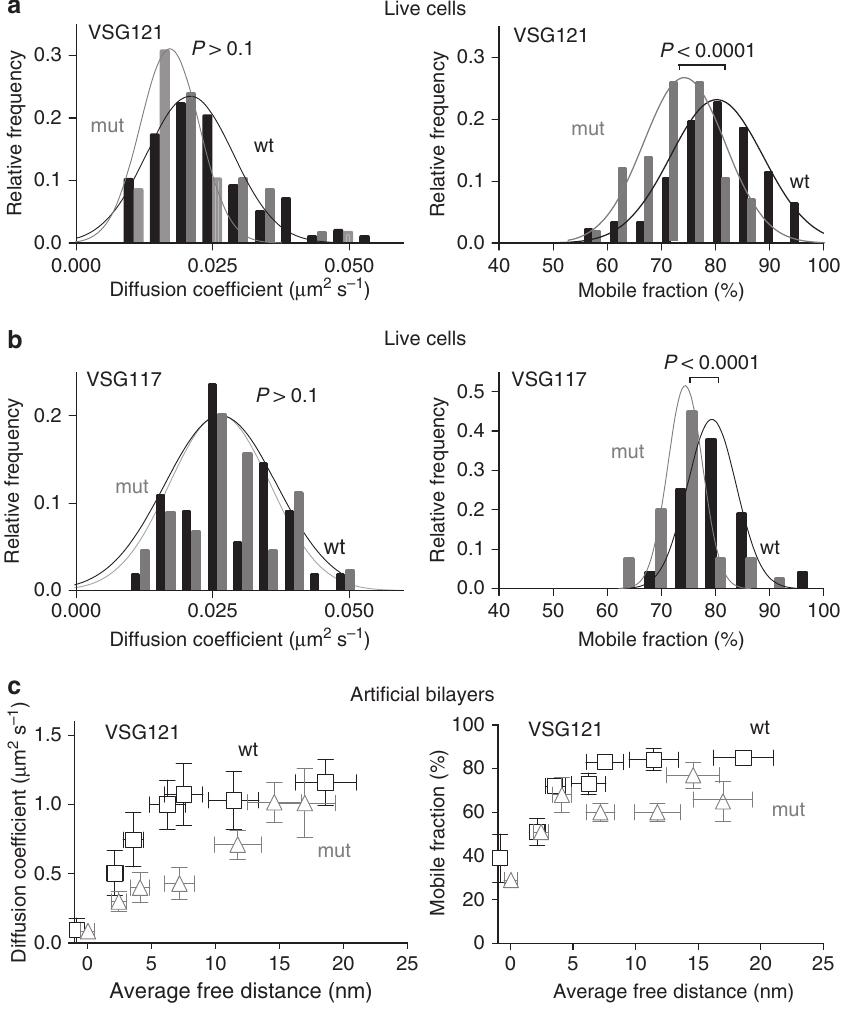
Figure 4 | Impact of N-glycosylation on the diffusion of VSG. The relative frequency distributions for wild-type (wt) and N-glycosylation deficient (mut) VSG121 ( a ) and VSG117 ( b ). Frequency distributions were fitted with a Gaussian function. The diffusion coefficients do not differ significantly, whereas there is a significant change in the mobile fractions of the wt and mut VSG. ( c ) Impact of the lateral protein density of wt and N-glycosylation deficient (mut) VSG121 on their diffusion in artificial membranes. The error bars in y (diffusion coefficient) represent the standard deviation of the mean, while the error bars in x (average free distance) depict the range. P values determined by an unpaired t